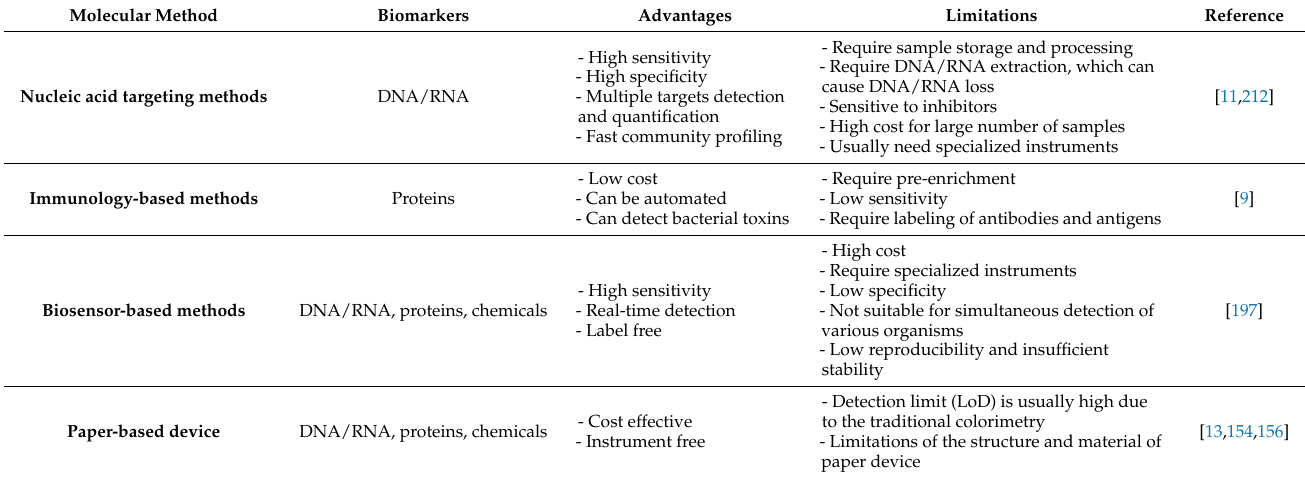
Table 6. Advantages, limitations, and prospects of various molecular methods in analyzing pathogenic bacteria for WBE